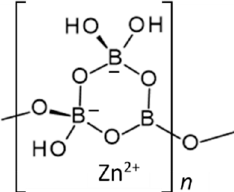
Figure 1. Schematic representation of the structure of Zn[B 3 O 4 (OH) 3 ] (ZnO ∙ 3B 2 O 3 ∙ 3H 2 O) [15].